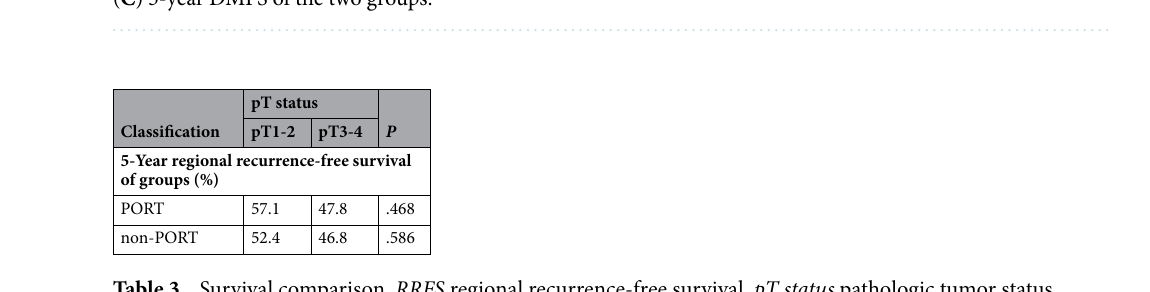
Figure 2. Kaplan–Meier curves for ( A ) 5-year RRFS of the two groups, ( B ) 5-year OS of the two groups, and ( C ) 5-year DMFS of the two groups.